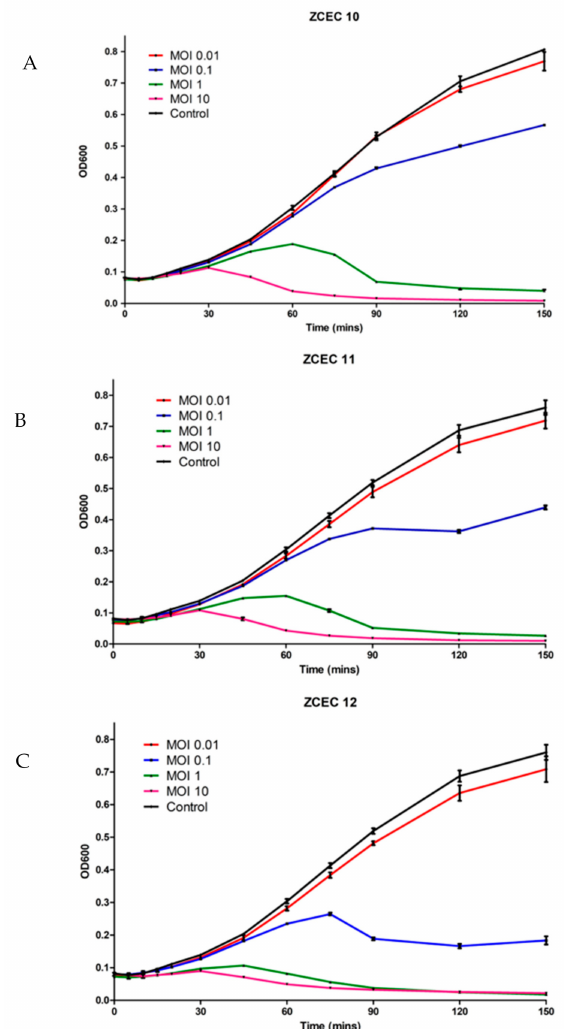
Figure 2. Time killing assay of phages against E. coli at 37 ◦ C. These panels show the bacterial count of E. coli as the control and bacterial survival infected with three different phages: ( A ) ZCEC10; ( B ) ZCEC11; ( C ) ZCEC12 at different MOIs (0.01, 0.1, 1, and 10). Optical density at 600 nm was measured every 10 min up to 2.5 h. MOI: Multiplicity of infection, OD: Optical density.